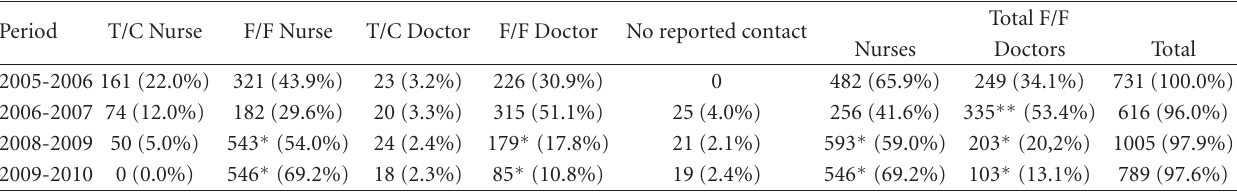
Table 2: Break down of first contact by members of the LOAP team. F/F: face to face, T/C: telephone contact. ∗ refers to joint (doctor/nurse) assessment ( n = 188; 18.7%; n = 121, 15.3% for 2008-2009 and 2009-2010 year, resp.). ∗∗ During this period there was a full time clinical trainee attached to the service.